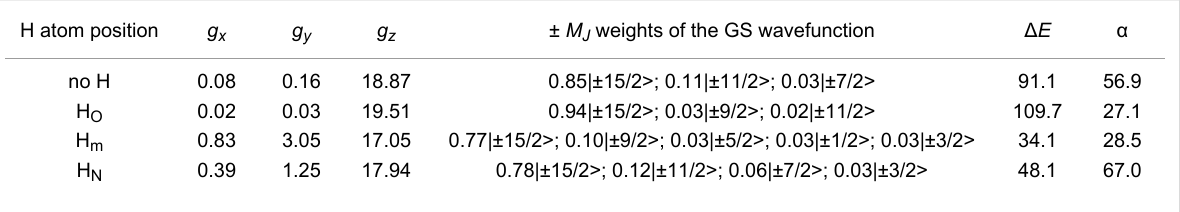
Table 1: Computed ground-state anisotropy tensor for Dy1 for different positions of the hydrogen atom involved in the hydrogen bond. The weights of the ± M J components of the calculated ground-state wavefunction, the relative energy of the first excited-state ( Δ E , cm − 1 ) and the angle ( α , degrees) between the experimental and computed easy axes are also given.